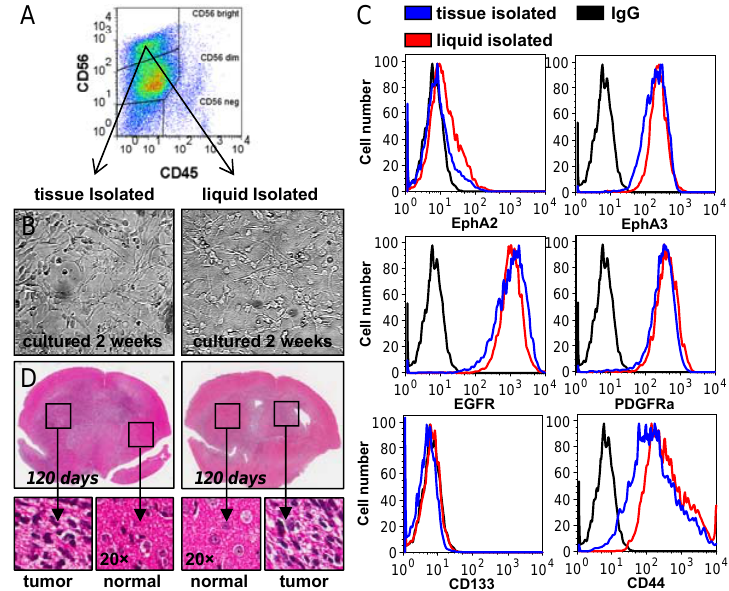
Figure 3. Tumor cells can be reliably isolated and analyzed from CUSA surgical aspirate. ( a ) Brain (normal and tumor) cells were selected by positive staining for neural cellular adhesion molecule (NCAM/CD56) which is expressed on neurons and glia; hematopoietic cells were excluded using CD45; ( b ) CD56 positive cells were isolated by cell sorting from dissociated tissue fragments and from single cells suspended in the liquid fraction of surgical aspirate. Both tissue and liquid isolated cells were grown as GNS and neurosphere cultures and survived for extended passage (>6). Cells isolated from these fractions exhibited identical cell morphology and growth characteristics; ( c ) Flow cytometric expression analysis of known glioma markers in the cultured tissue and liquid fractions revealed similar expression patterns identifying that tumor cells could be cultured from both these fractions; ( d ) The tumorigenic potential of the tissue and liquid isolated cell populations was determined by orthotopic (intracranial) injection. 1 × 10 5 cells were injected into the right hemisphere of immuno-compromised NOD/SCID mice. H&E sections revealed invasive tumors formed throughout the brain in 120 days using both cultured tissue and liquid isolated tumor